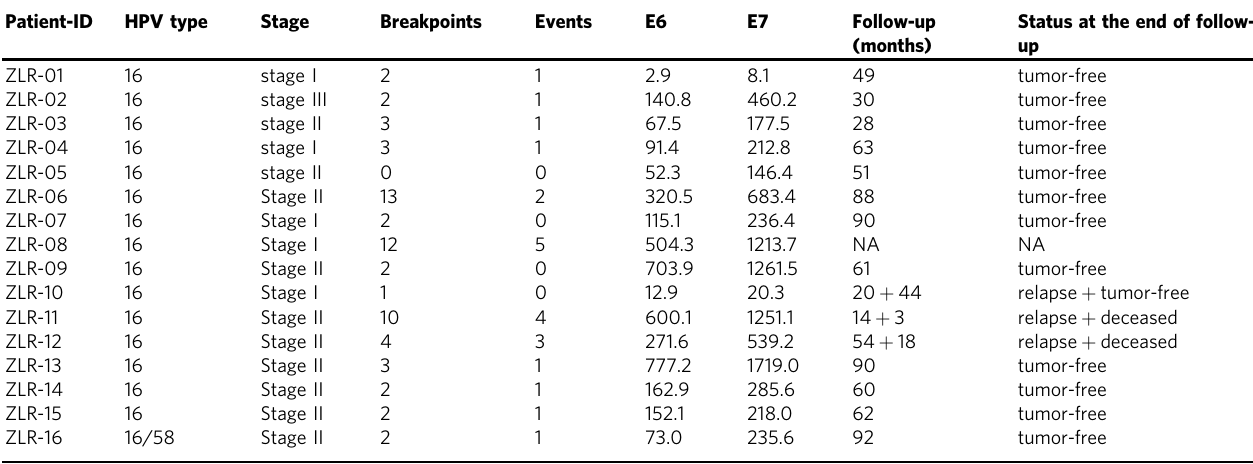
Table 1 Characteristics of the 16 tumor samples and the number of breakpoints and integration events detected in these